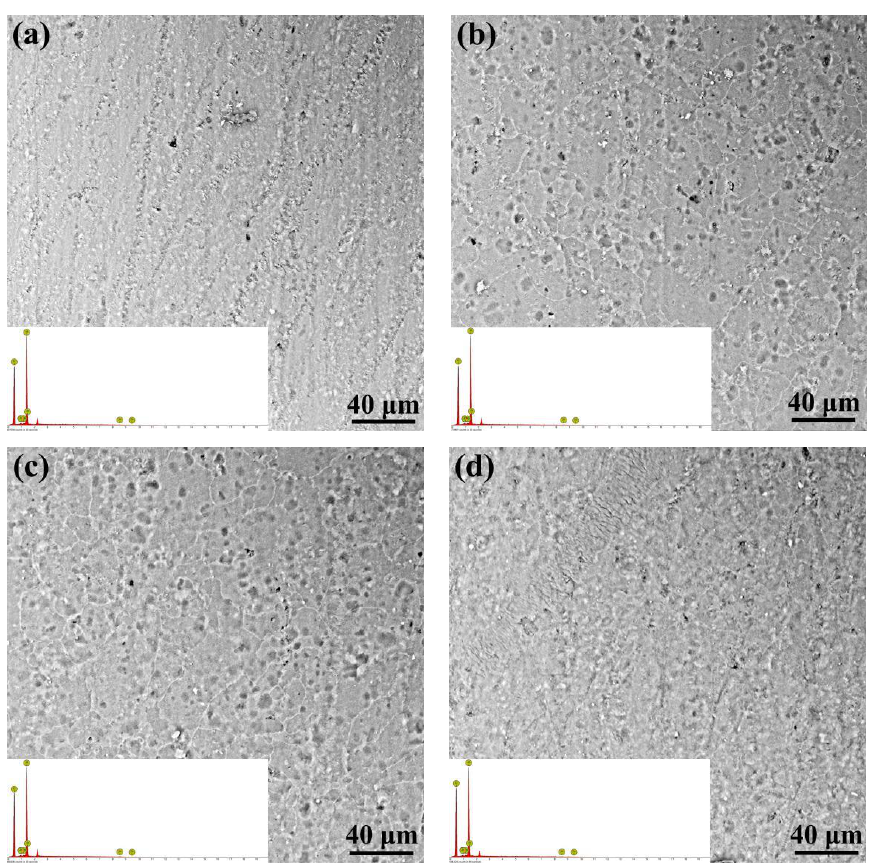
Figure 8. Surface morphology of the Al alloy joining interface with different anodizing pretreat- ment: ( a ) anodizing time of 5 min, ( b ) anodizing time of 10 min, ( c ) anodizing time of 15 min, and ( d ) anodizing time of 20 min (inset image showing the energy-disperse spectroscopy (EDS) of the corresponding surface).